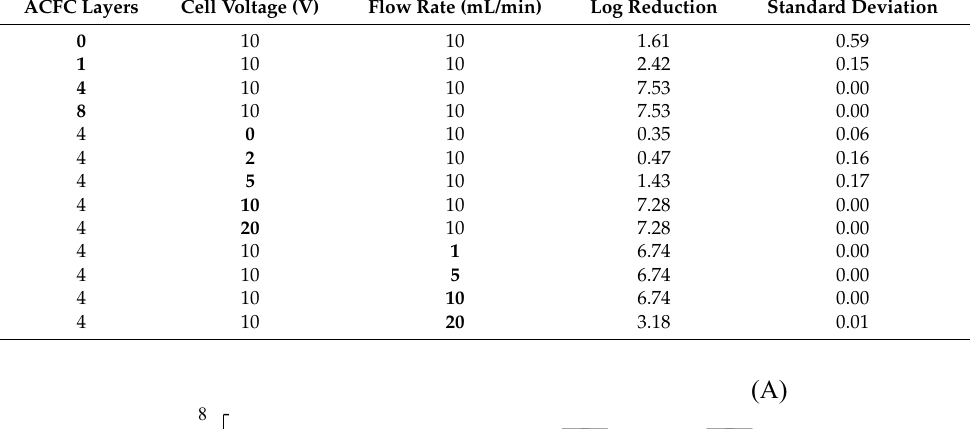
Table 1. The conditions of REM treatment experiments and the results of bacterial log reduction. The conditions that were varied in each test series are indicated in bold.